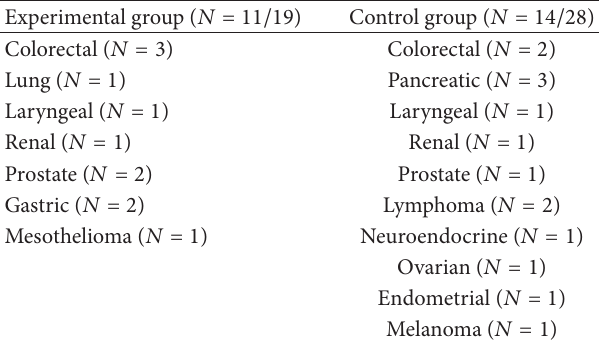
Table 1: Number and types of malignancies in each patient